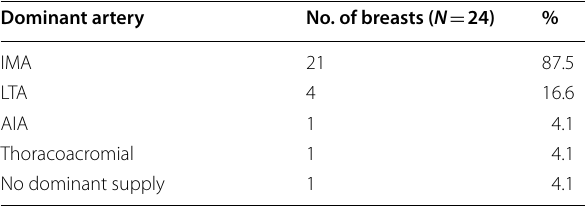
Table 2 Dominant arterial supply to NAC based on CTA